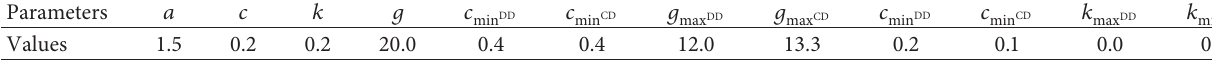
Table 2: Values of the capacity-sharing system parameters.